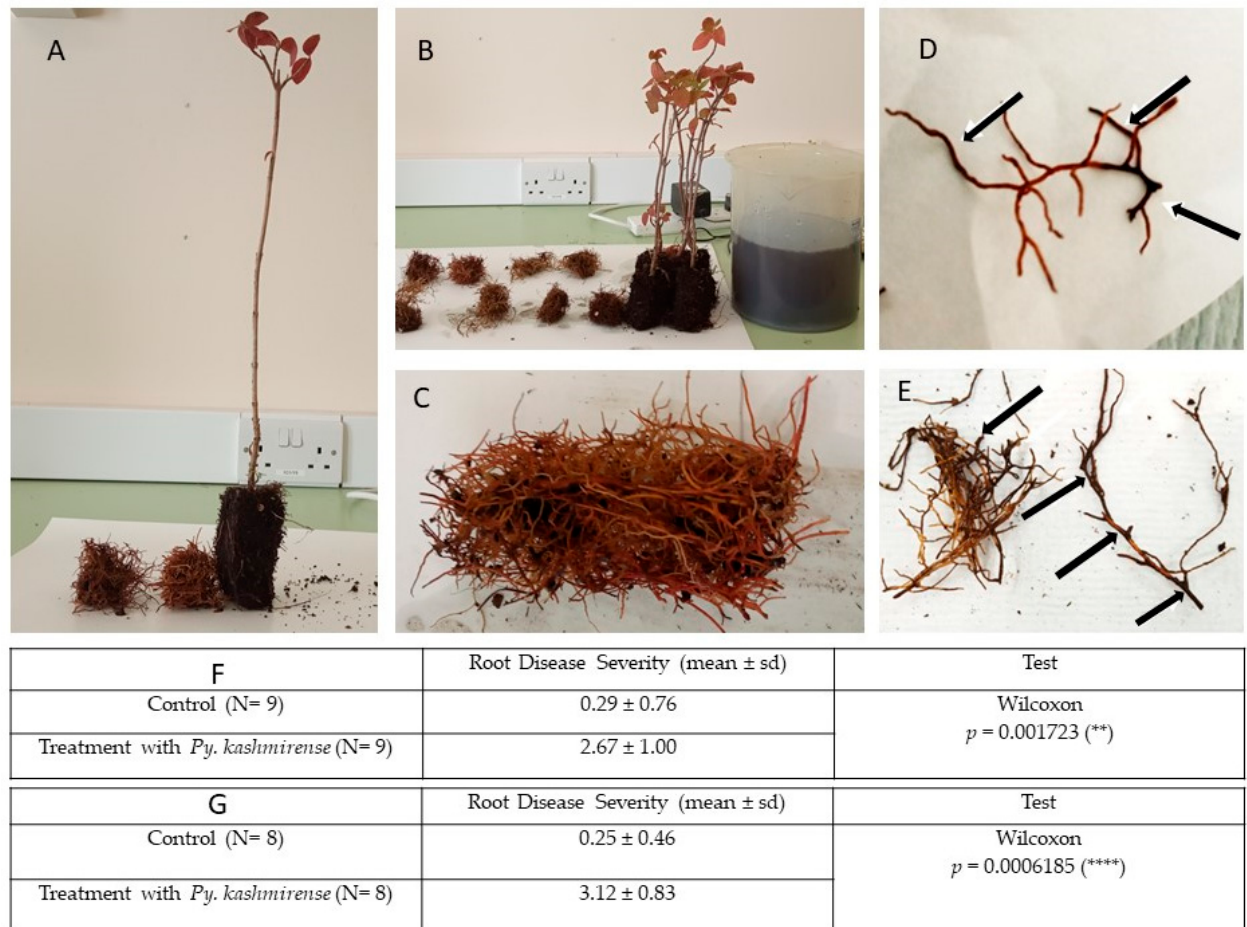
Figure 6. Inoculation of Viburnum opulus roots with Py. kashmirense . ( A , B ) Healthy seedlings of Viburnum opulus ; ( C ) Healthy root system of Viburnum opulus cleaned with sterile distilled water; ( D , E ) Viburnum opulus roots after inoculation with Pythium kashmirense in vitro, showing discoloration and necrosis on around the 40 to 50% of the root segments; ( F ) Data analysis of Viburnum opulus Root Disease Severity in the in vitro assay; ( G ) Data analysis of Viburnum opulus Root Disease Severity in the in vivo assay. NS means p > 0.05, ** means p ≤ 0.01, **** means p ≤ 0.0001.